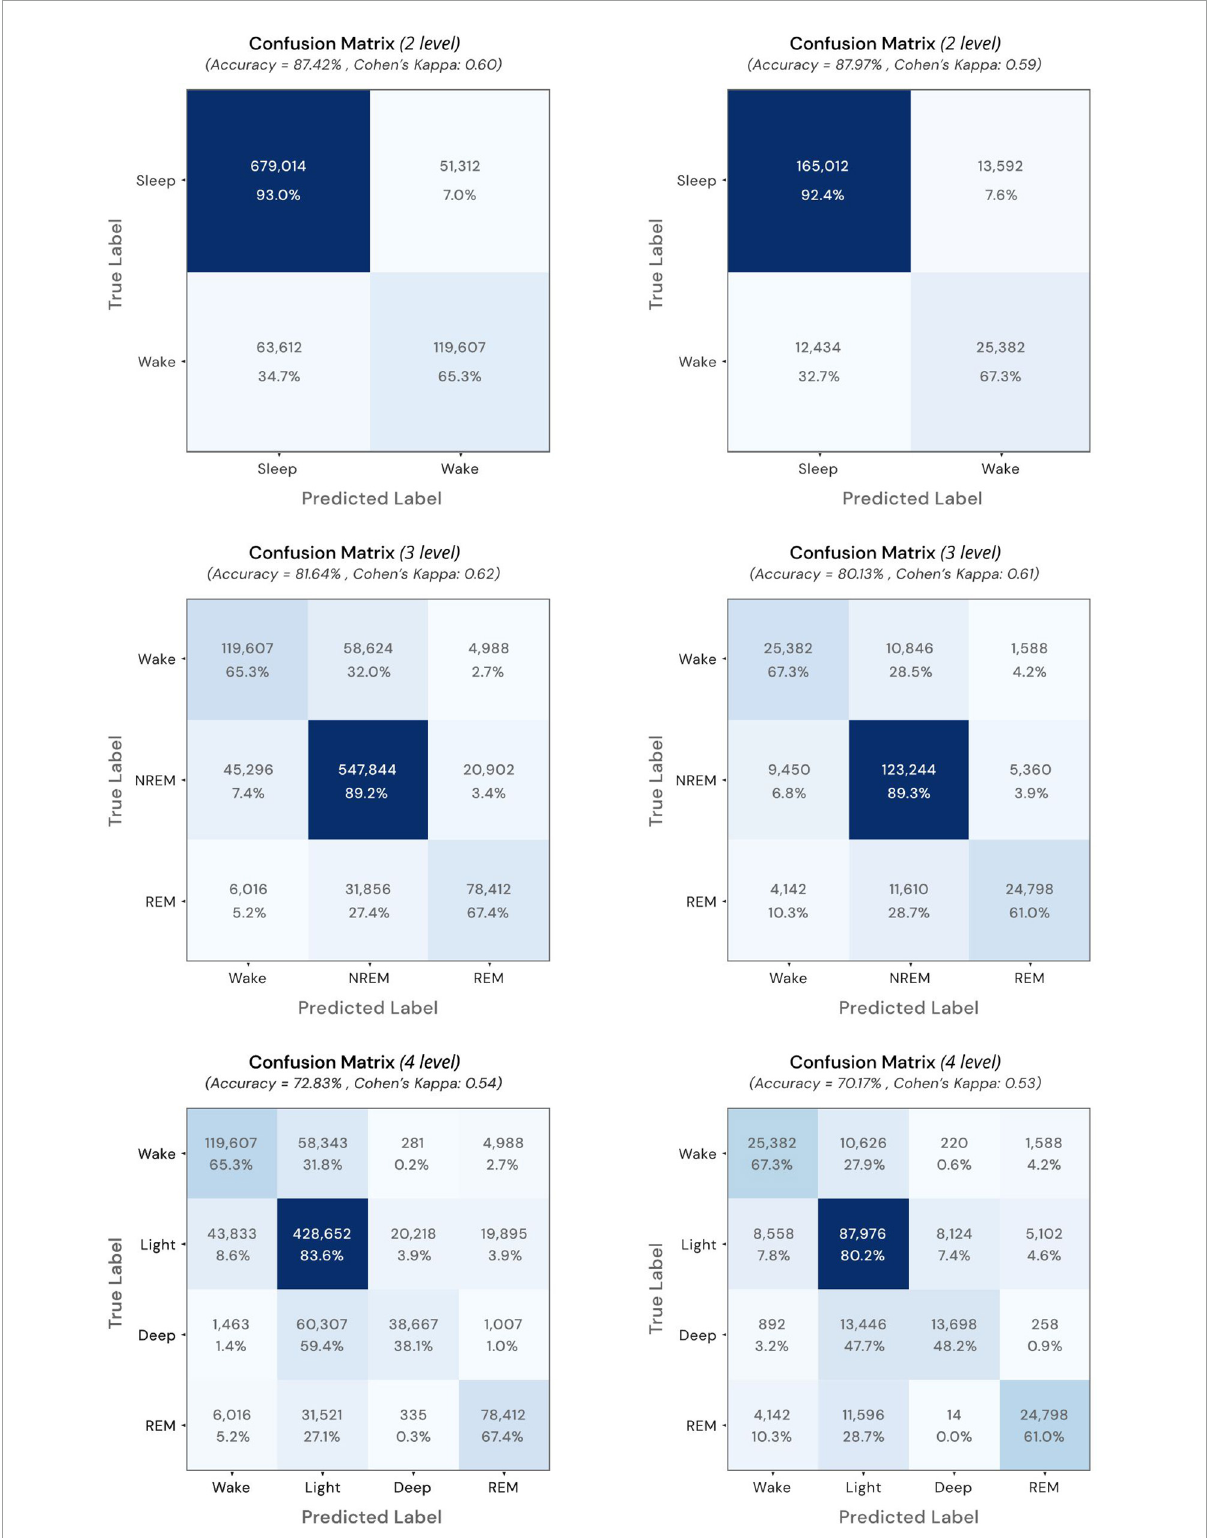
Figure3 Full-counts and normalized confusion matrices for results of the 2-, 3-, and 4-levels prediction for the CinC dataset (Left column) and Z3Pulse dataset (Right column)